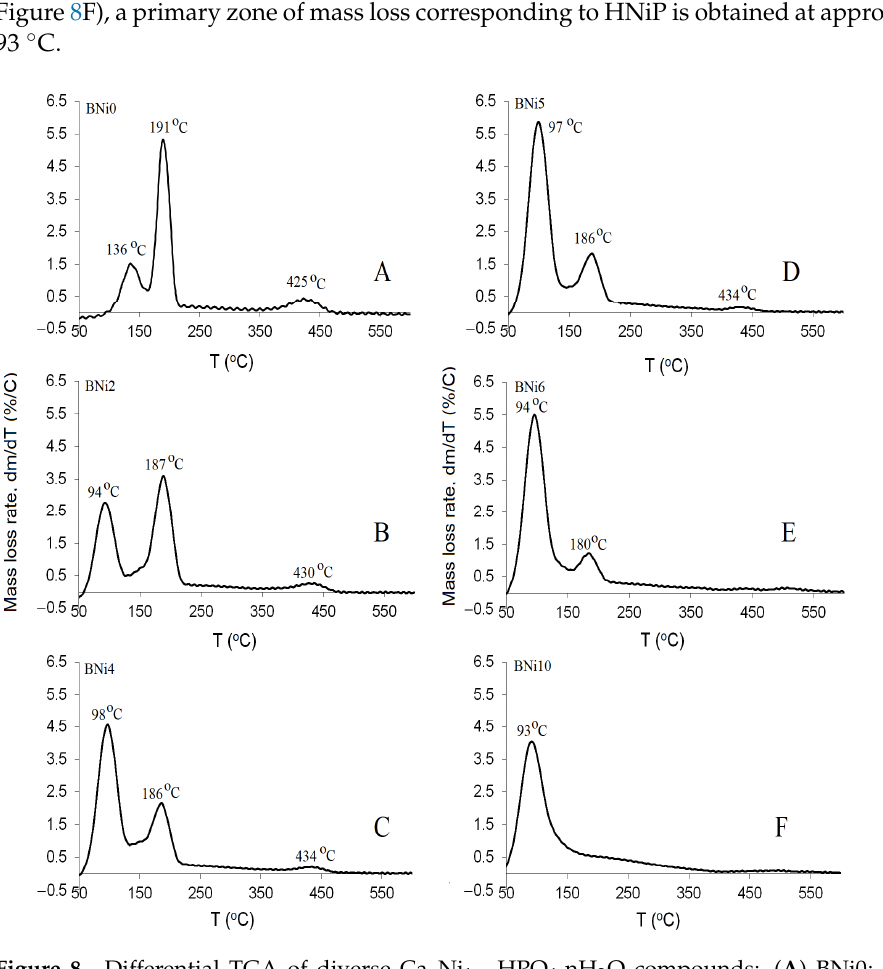
Table 4. Phase evolution, crystal size, and structure as a function of the Ni/Ca molar ratio in solu- tion.